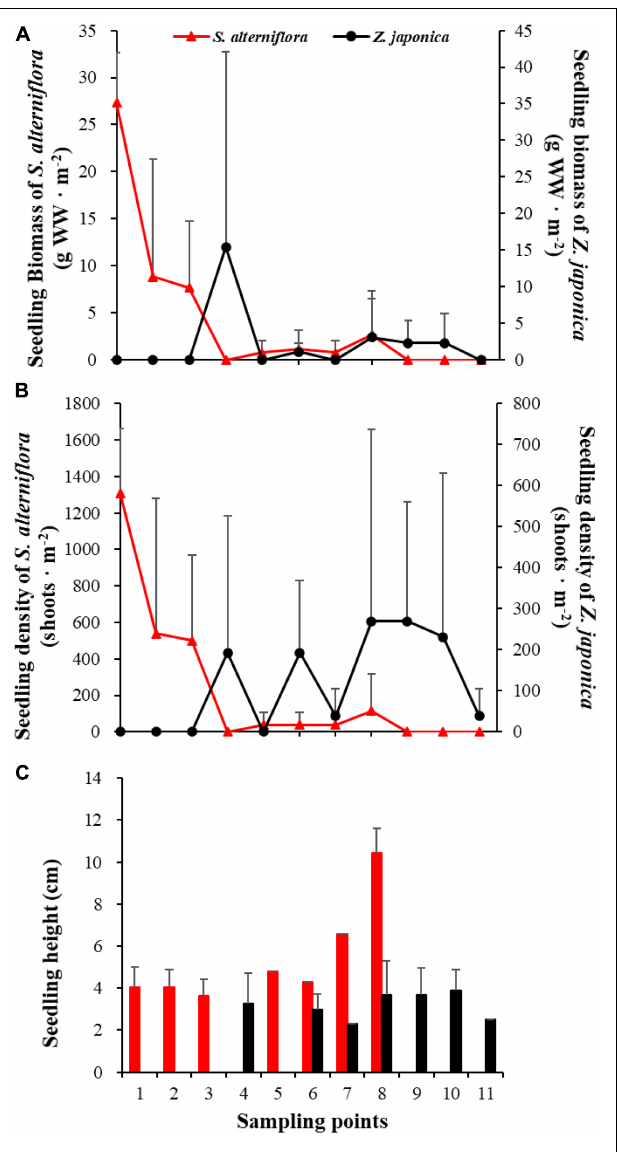
FIGURE 7 | Seedling biomass (A) , density (B) , and height (C) of Spartina alterniflora and Zostera japonica at the 11 sampling points in April 2019. Values are mean ± SD.